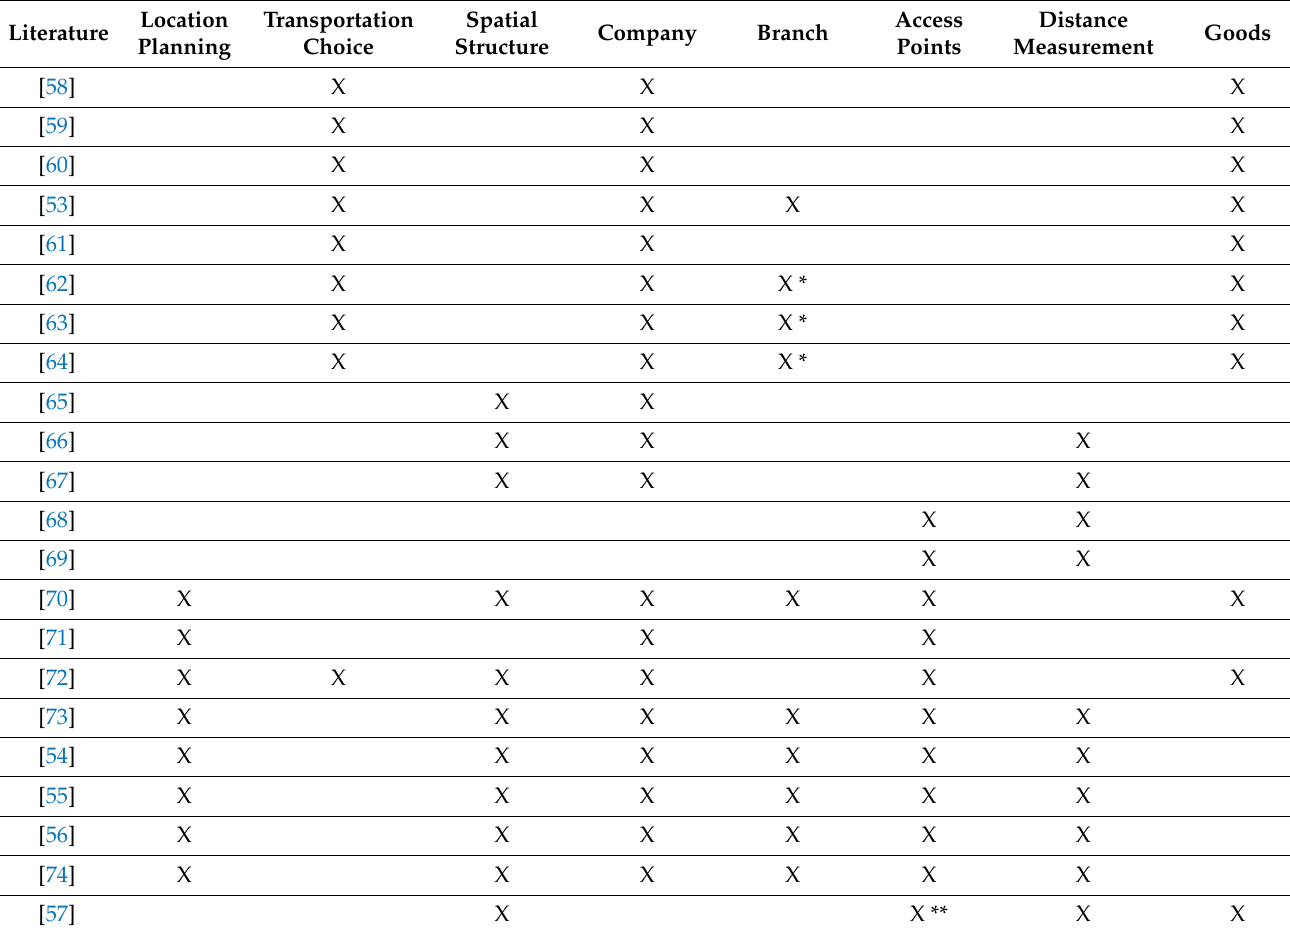
Table 1. Literature concerning business locations and proximity to transport infrastructure 1